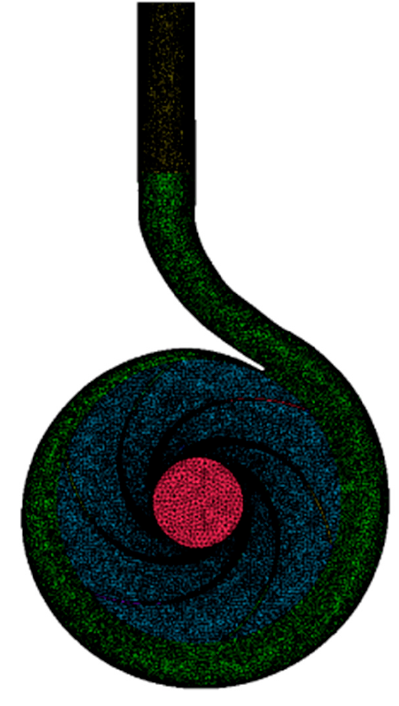
Figure 1. Sketch of the centrifugal pump model.